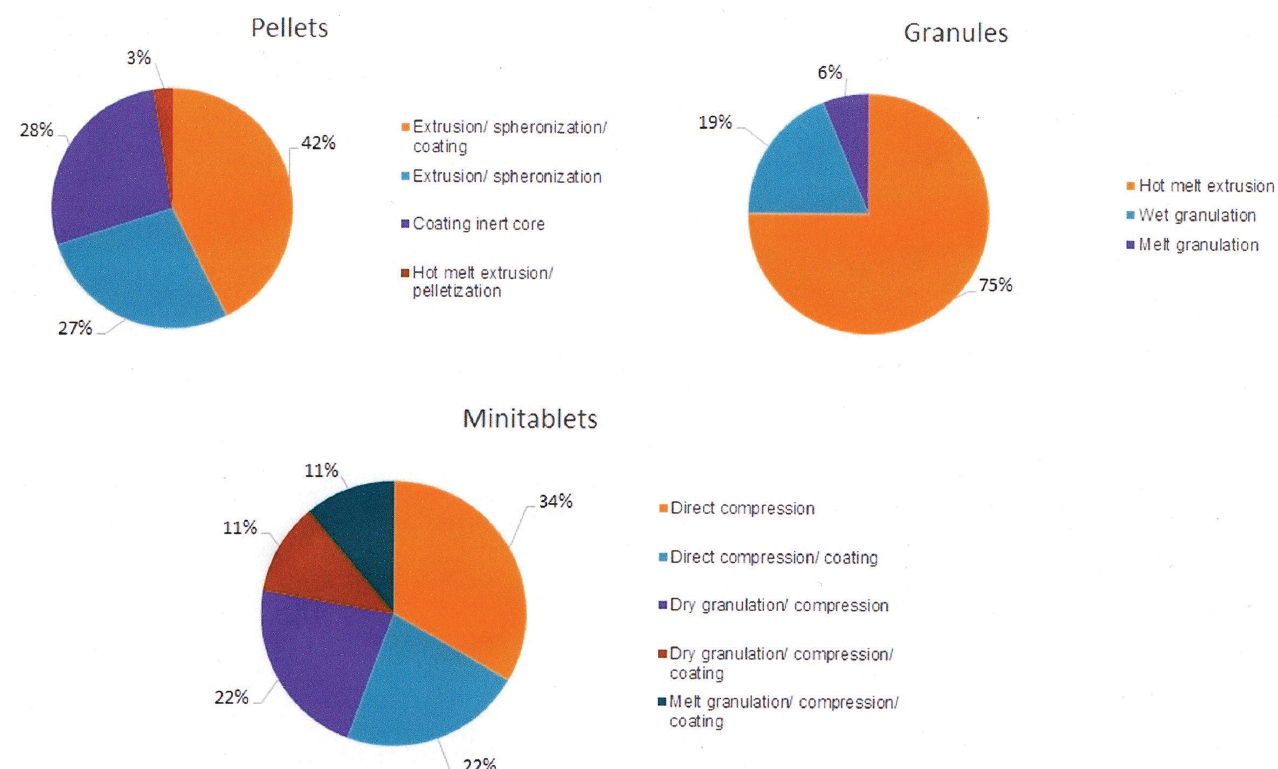
FIGURE 1 - Technologies used in production of pellets, granules and minitablets. The information for charts was based on 65 articles on multiparticulate systems published in the 2003-2015 period and retrieved from the Science Direct and SciFinder